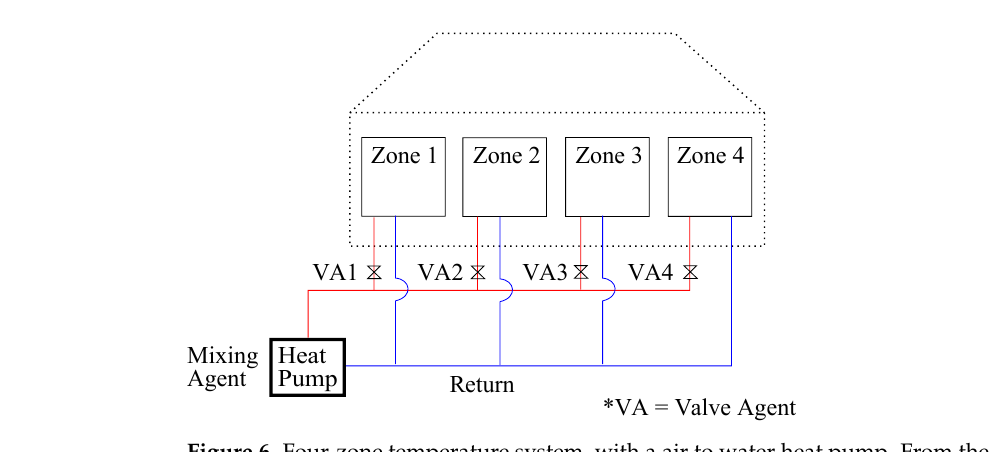
Figure 6. Four-zone temperature system, with a air to water heat pump. From the illustration, it can be seen how the agents are divided into one mixing agent and four valve agents. The mixing agent controls the supply temperature and the valve agents control the flow to each zone.